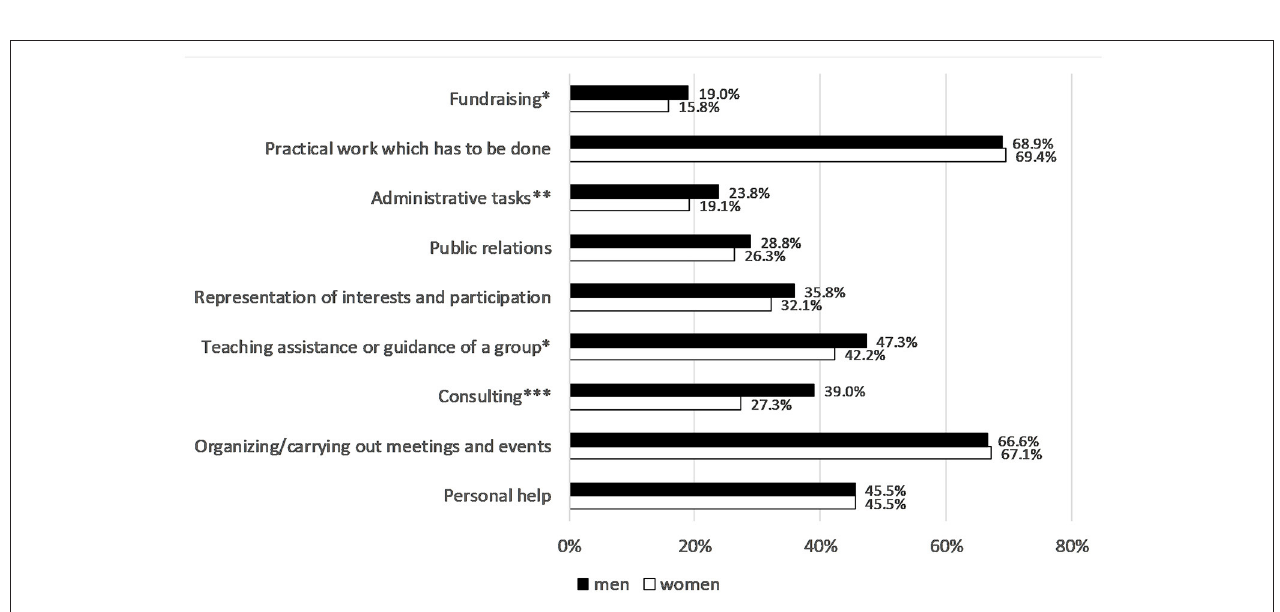
FIGURE 4 | Content of volunteer activities in 2019. Approval ratings in %, gender differences using Chi 2 test: * p < 0.05, ** p < 0.01, *** p < 0.001. German Survey on Volunteering (FWS).